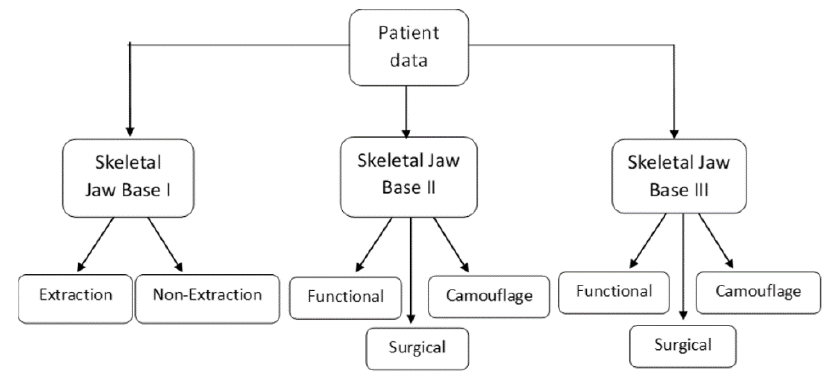
Figure 1. Outline of orthodontic diagnosis and treatment